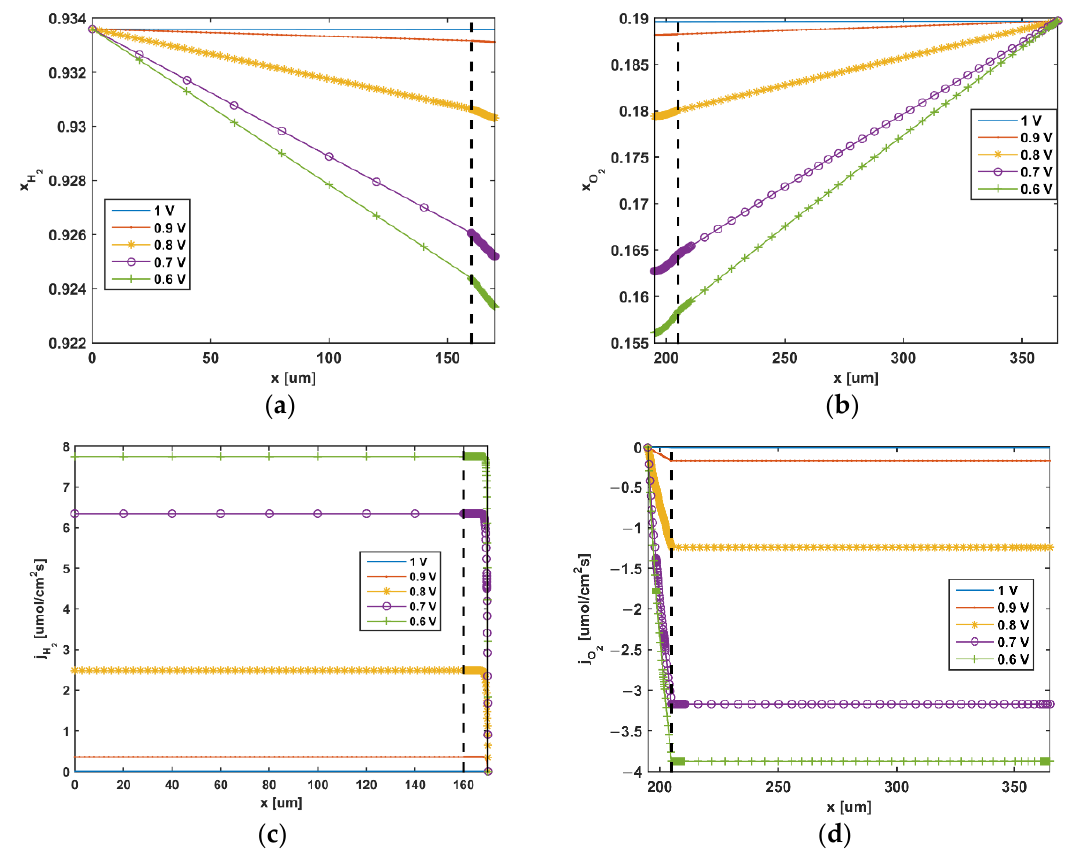
Figure 8. Evolution of the gas profiles on through-plane ( a ) hydrogen diffusion profile; ( b ) oxygen diffusion profile; ( c ) hydrogen flux profile; ( d ) oxygen flux profile.